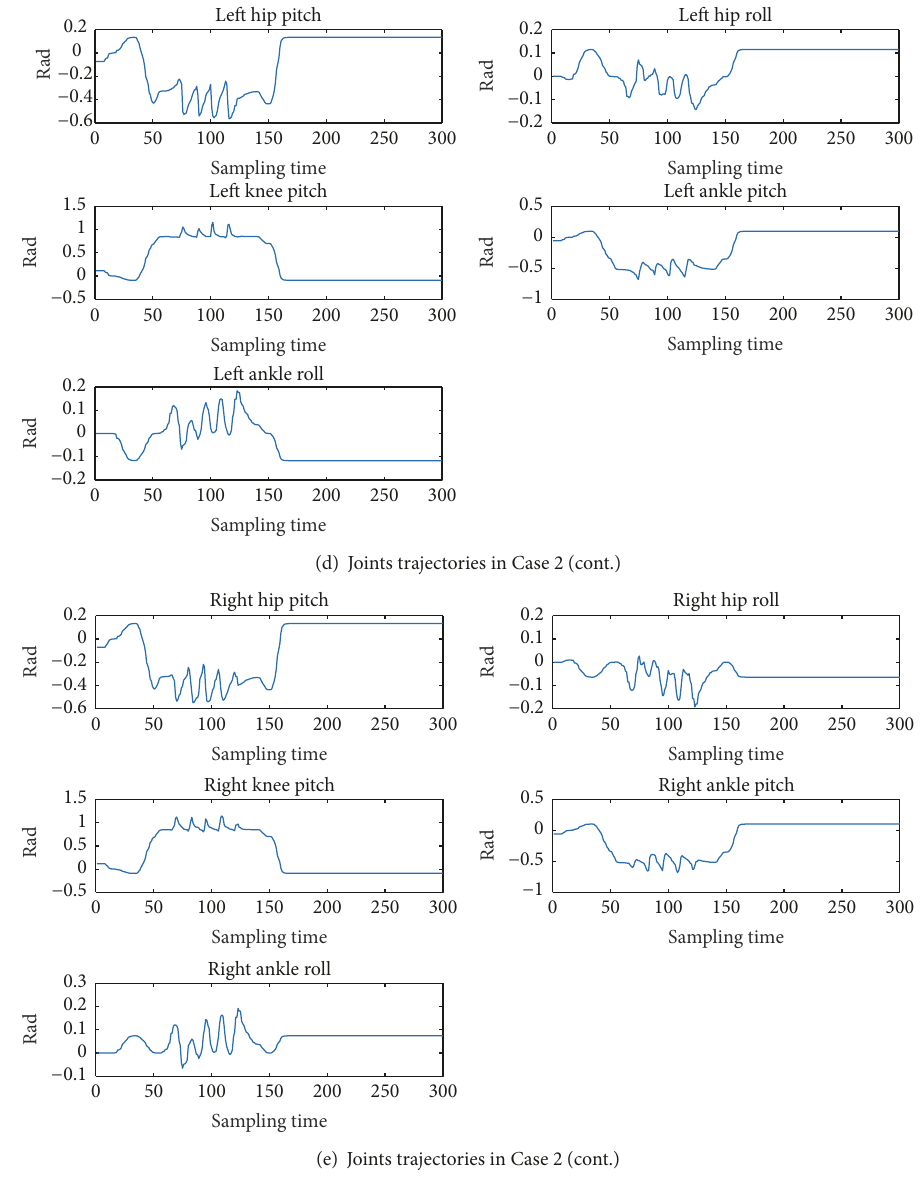
Figure 10: Joints trajectories in online